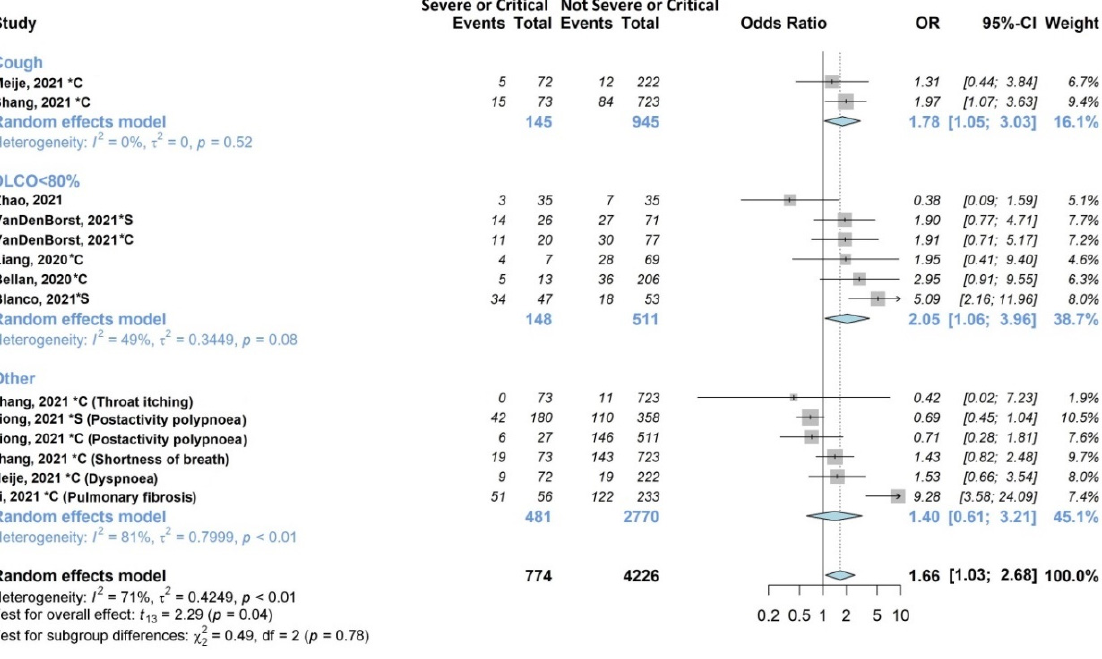
Figure 4. Forest plots of adjusted analyses for association between acute disease severity and respiratory symptoms. HKSJ, Hartung-Knapp-Sidik-Jonkman.